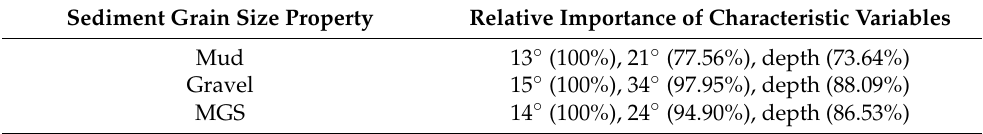
Table 5. The relative importance of characteristic variables for predicting the sediment properties explained by the